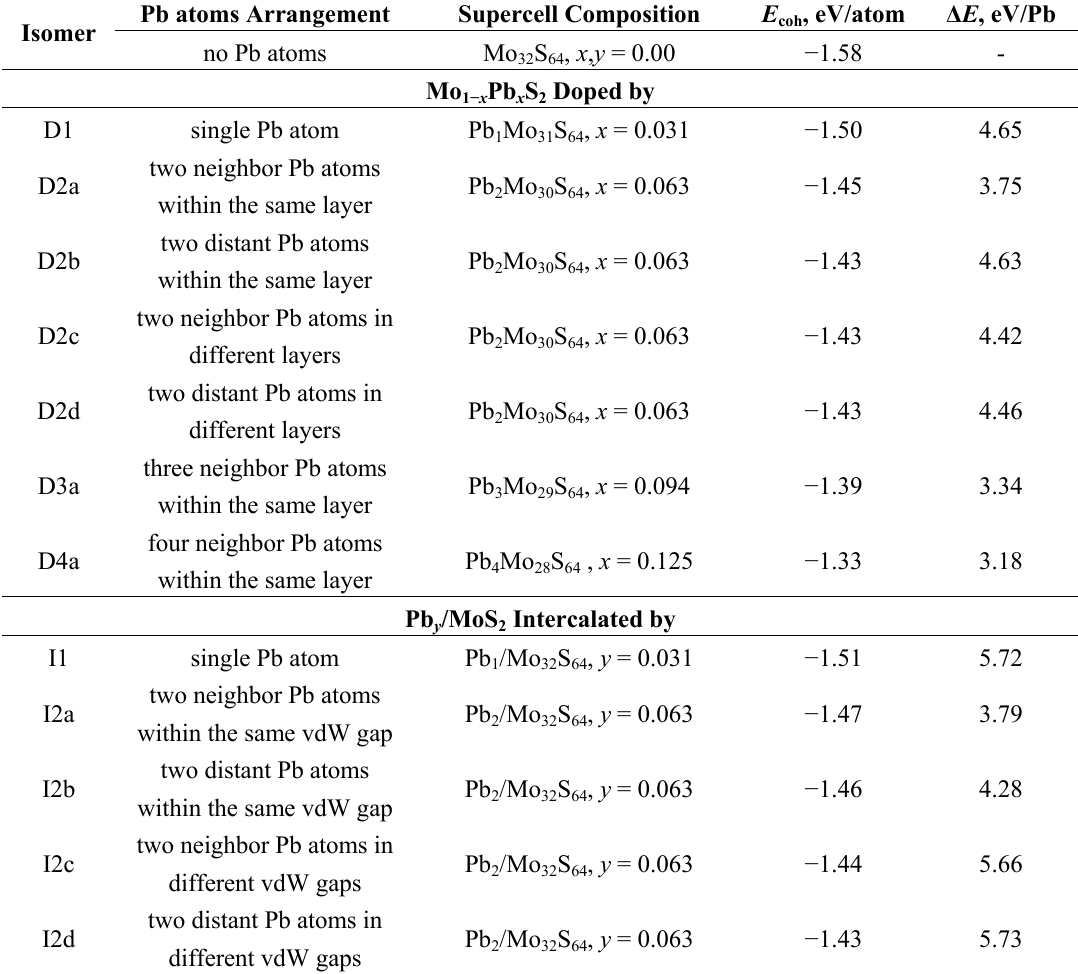
Table 2. Cohesion energies E solutions and Pb content and the arrangement of Pb atoms within model supercells. LDA DFT calculations.